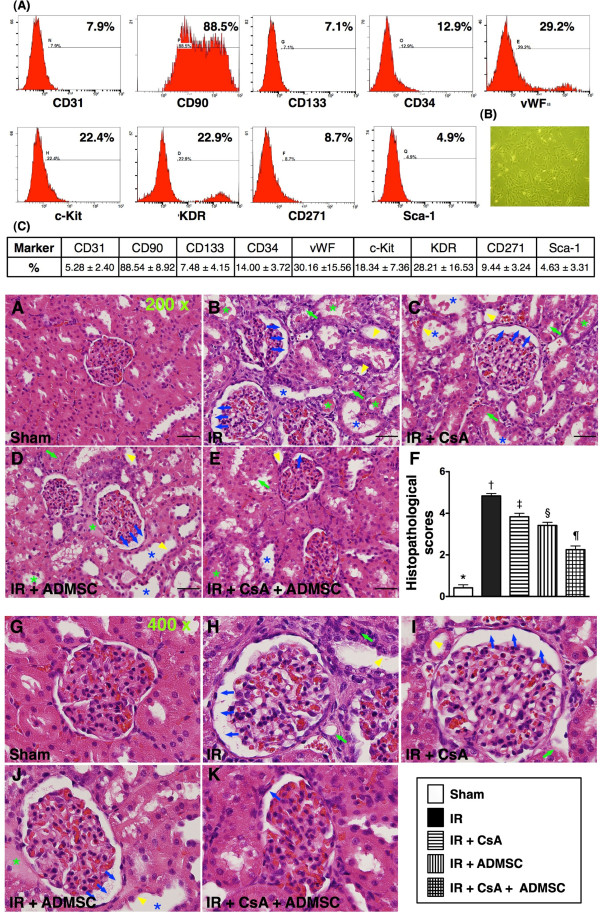
Flow cytometry and microscopy analysis of rat adipose-derived mesenchymal stem cells and histopathological scoring of renal injury. Flow cytometric analysis and microscopy findings of rat adipose-derived mesenchymal stem cells (ADMSCs) (n = 6) and histopathological scoring of acute kidney ischemia–reperfusion (IR) injury at 72 hours after the IR procedure (n = 8). Upper panel: (A) Flow cytometric results of rat ADMSCs and endothelial progenitor cells (EPC) on day 14 after cell culturing showed that CD90+ cells contributed the highest population of stem cells (n = 6). (B) Spindle-shaped morphology of stem cells illustrated in the lower right corner (200×). (C) Percentage of ADMSCs and EPC shown was the mean value of n = 6. Lower panel: (A) to (D), (G) to (K) H & E staining (200× in (A) to (E), and 400× in (G) to (K)) of kidney sections in sham control, IR, IR + cyclosporine (CsA), IR + ADMSCs and IR + CsA + ADMSCs, showing significantly higher degree of loss of brush border in renal tubules (yellow arrowheads), cast formation (green asterisk), tubular dilatation (blue asterisk), tubular necrosis (green arrows), and dilatation of Bowman’s capsule (blue arrows) in the IR without treatment group than in other groups at 72 hours after IR procedure. (F) *P <0.0001 vs. other groups with different symbols; † vs. ‡ vs. ¶ vs. §, all P <0.05 for inter-group comparisons. All statistical analyses were with one-way analysis of variance followed by Bonferroni multiple comparison post-hoc test. Different symbols (*, †, ‡, ¶, §) among different groups indicate significance (at 0.05 level). Scale bars in right lower corner = 50 μm.